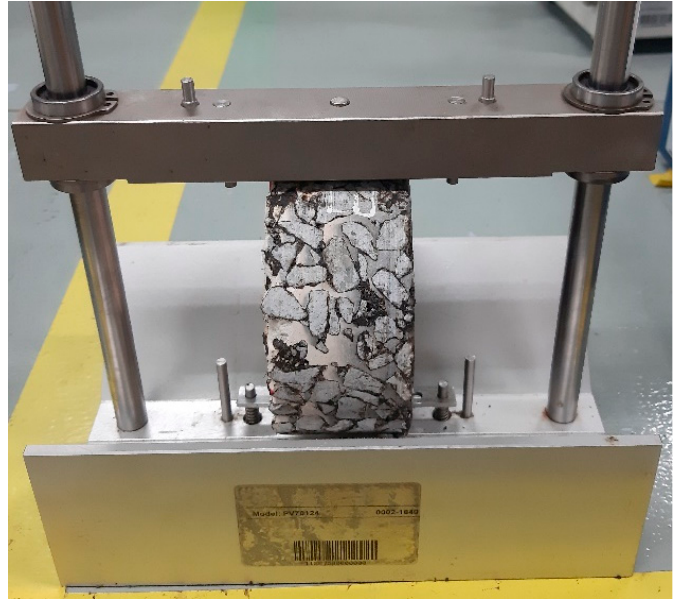
Figure 3. Positioning rig for positioning and gluing the deformation strips on the specimen.